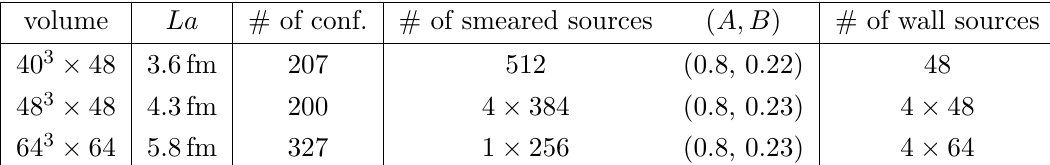
Table 1 . Simulation parameters. The rotational symmetry for isotropic lattice is used to increase